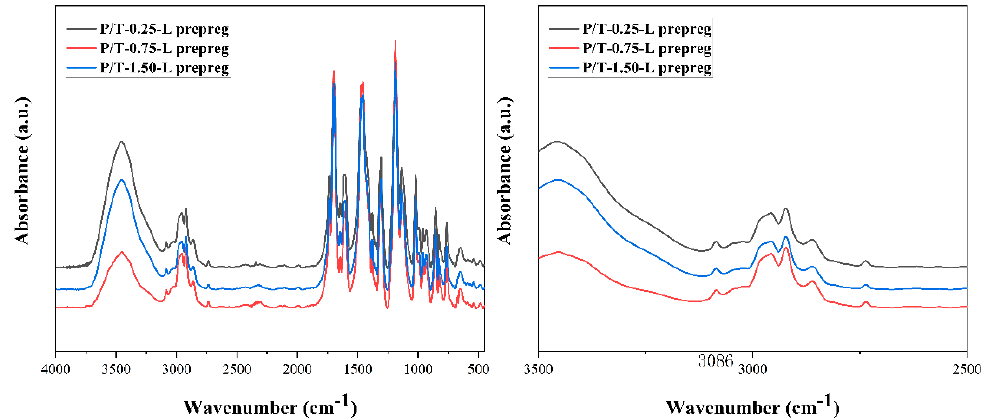
Figure 11. DSC curves of P/T-0.25-L and TAIC homopolymerization system (the mass ratio of TAIC: BIPb was 99:1).